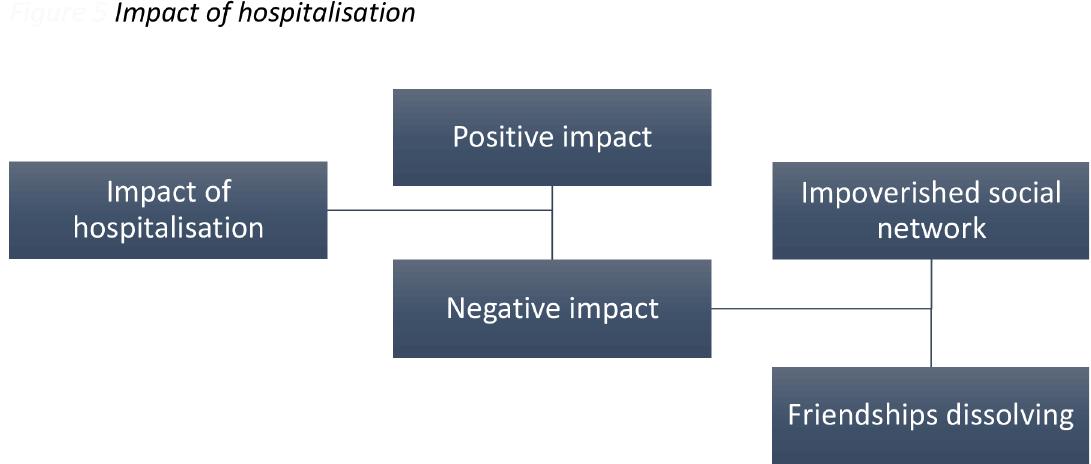
Fig 5. The furthest left hand box indicates the superordinate themes, with the subordinate themes in the remaining boxes. The connecting lines indicate the hierarchical organisation of the themes.